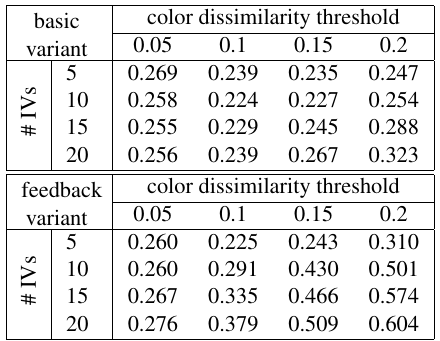
Table 4. Outlier ratios of the basic and feedback variant in se- quence 2011_09_26_drive_0013 of the KITTI raw data record- ings for various parameters